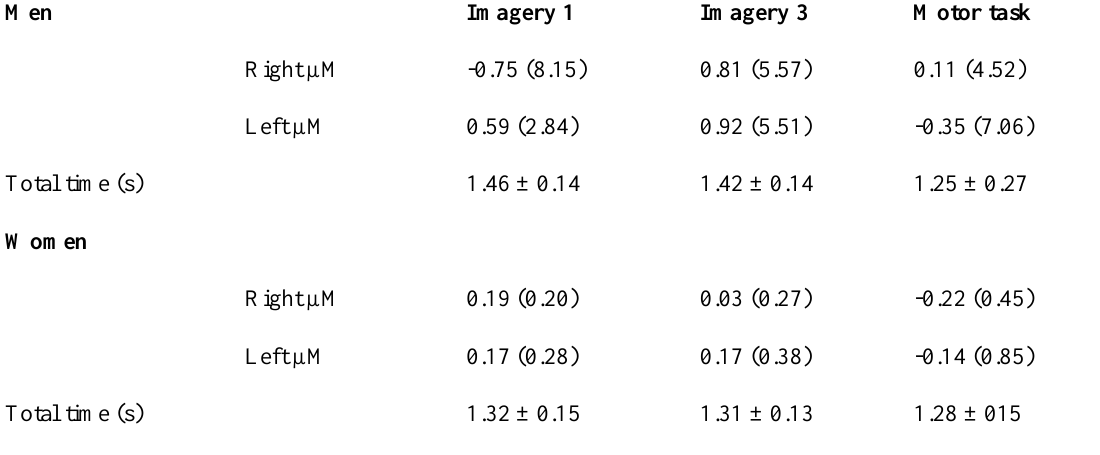
Table 1. dlPFC blood flow variations. Data are presented in median and interquartile ranges for right and left variables, and in mean and standard deviation for total time